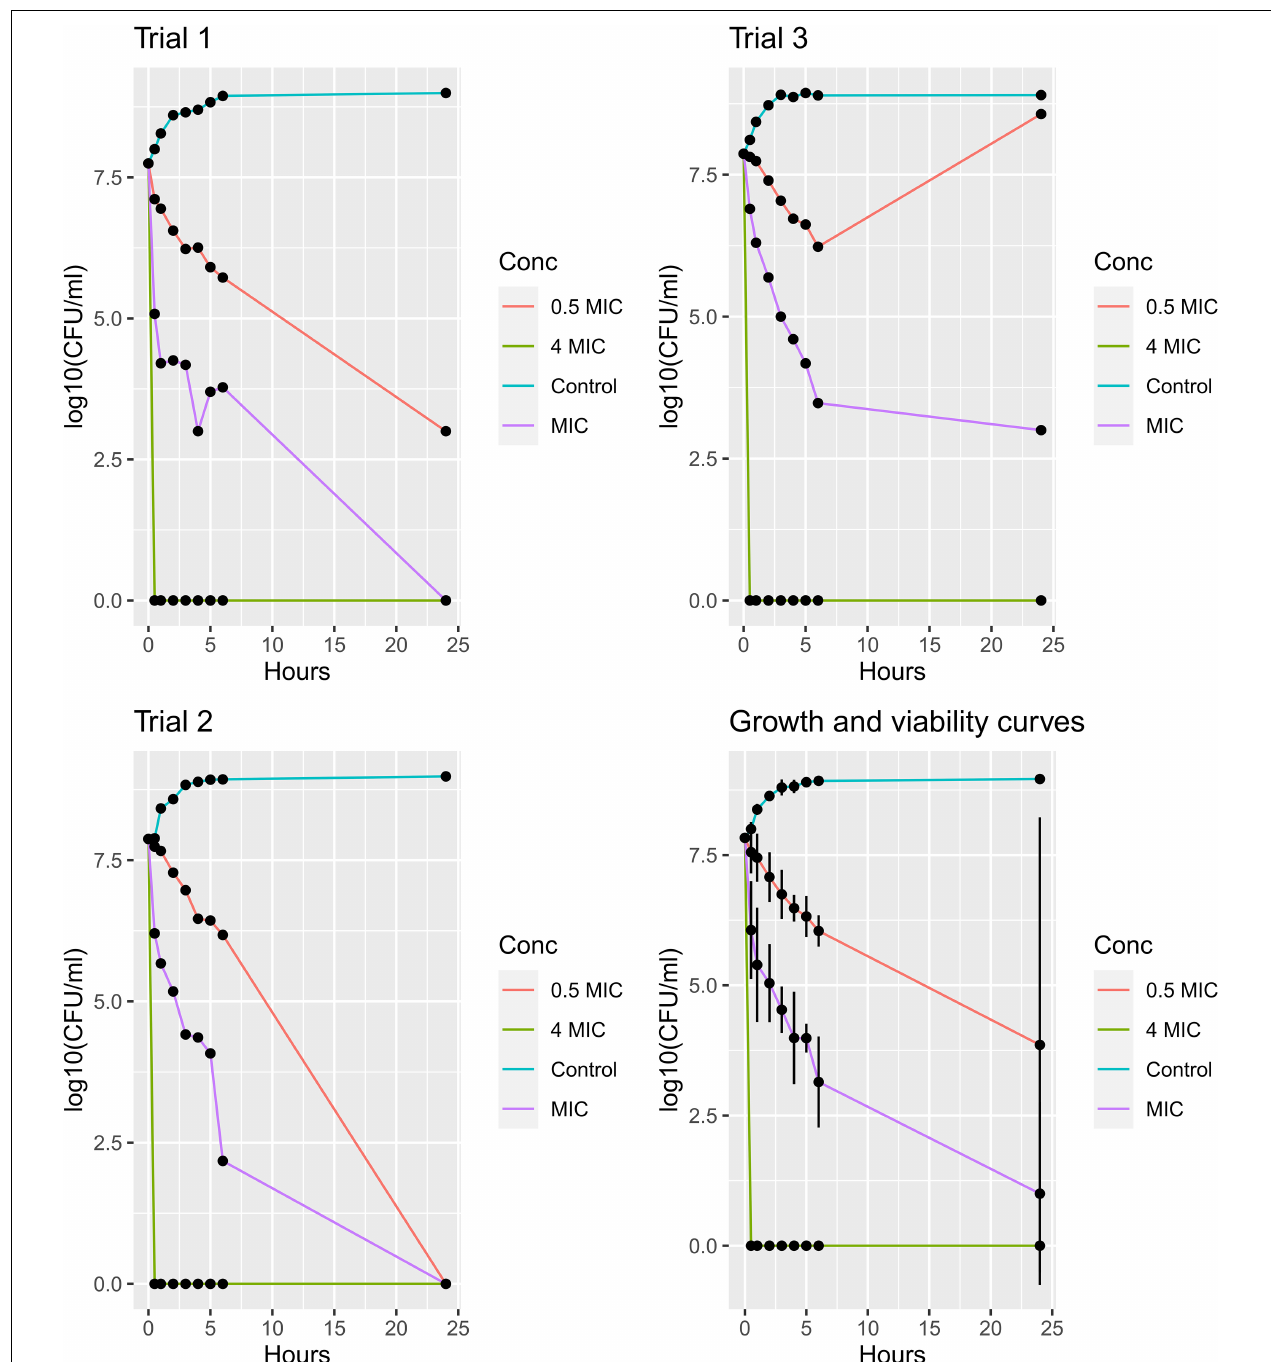
FIGURE 2 | Growth and viability assay. The plots show growth and viability curves for Staphylococcus aureus USA300 JE2 exposed to JBC 1847 in three concentrations (0.5 × MIC, MIC, and 4 × MIC) together with an untreated control for 24 h. The assays were performed in triplicates (trials 1, 2, and 3), and the mean numbers of the bacterial concentrations [log10(CFU/ml)] from all triplicates including standard deviations presented as error bars, are shown in the plot at the bottom